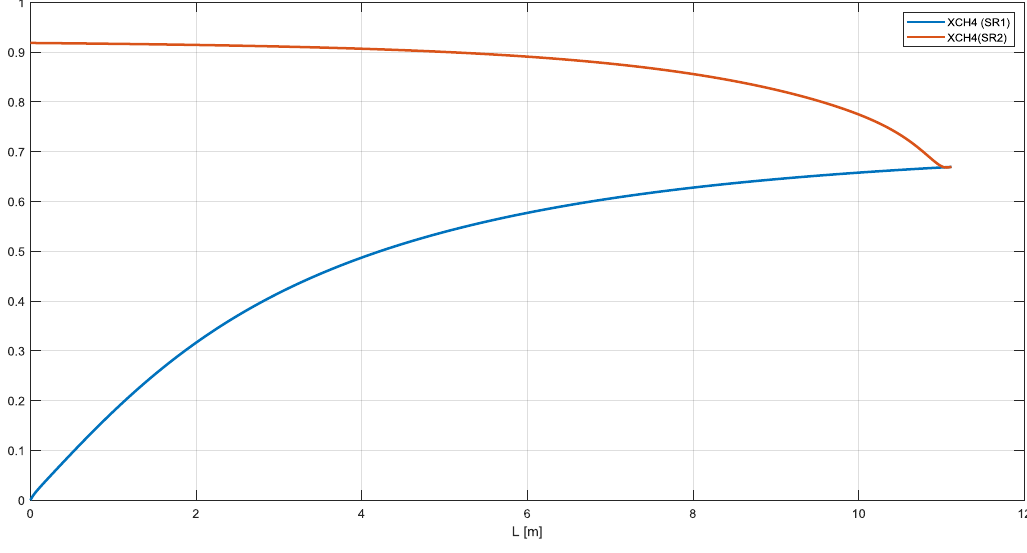
Figure 9. Overall methane conversion in RMM.